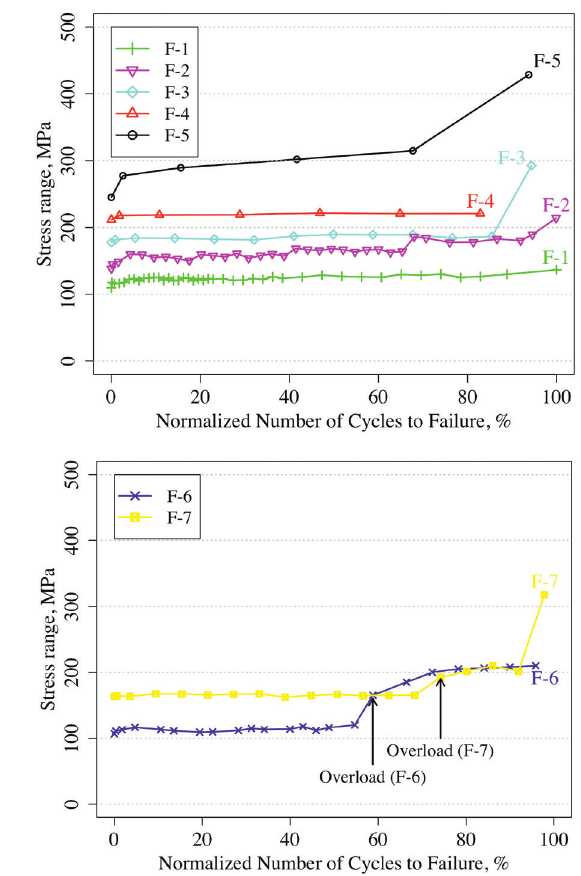
Figure 8. Stress range variations in the outmost tensile reinforcing bars for beams a) F-1 to F-5 and b) F-6 &